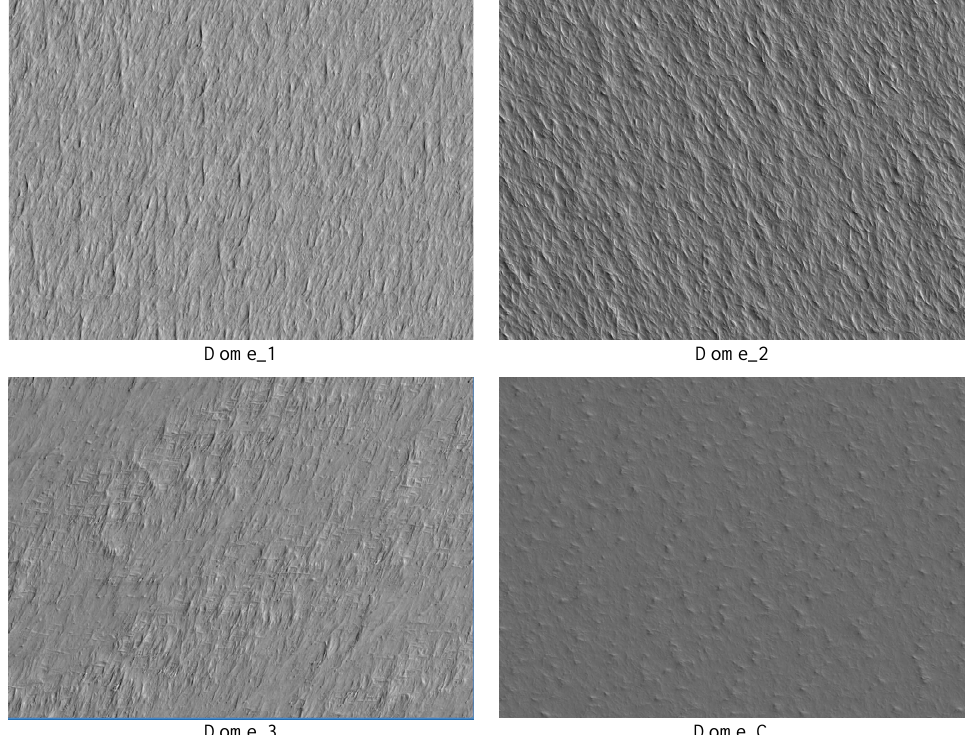
Figure 4 : PLEIADES panchromatic acquisitions of the Dome sites (spatial resolution : 70